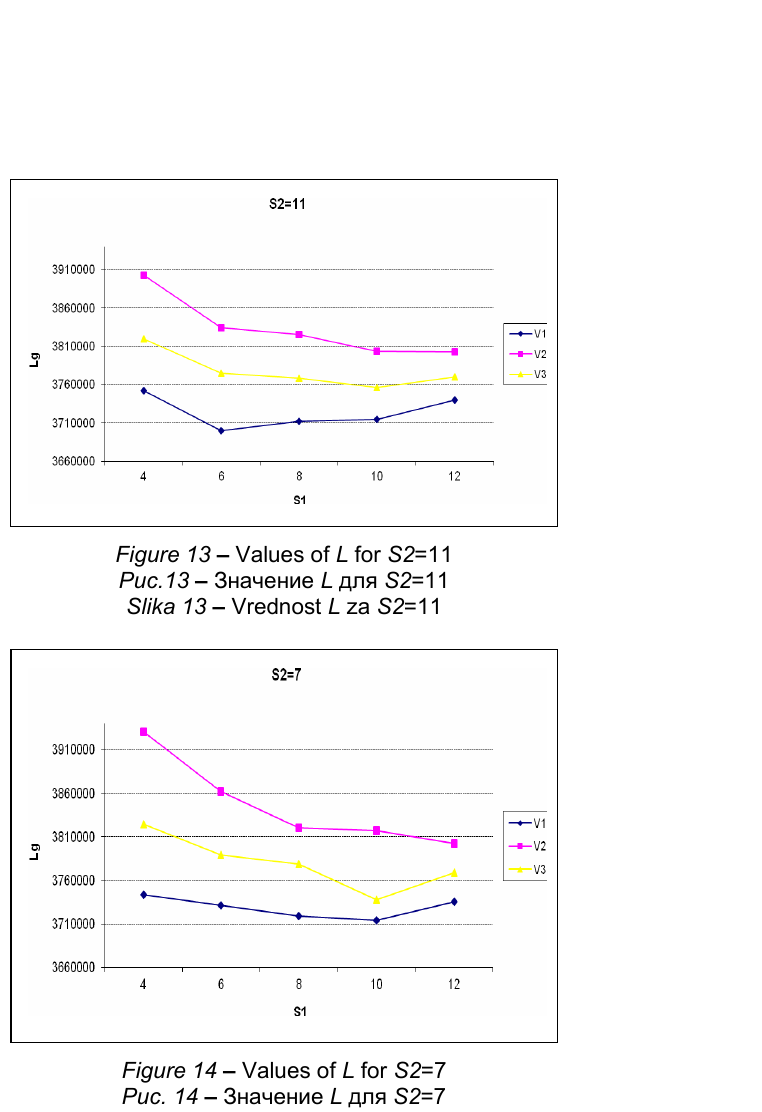
Figure 14 – Values of L for S2 =7 Рис . 14 – Значение L для S2 =7 Slika 14 – Vrednost L za S2